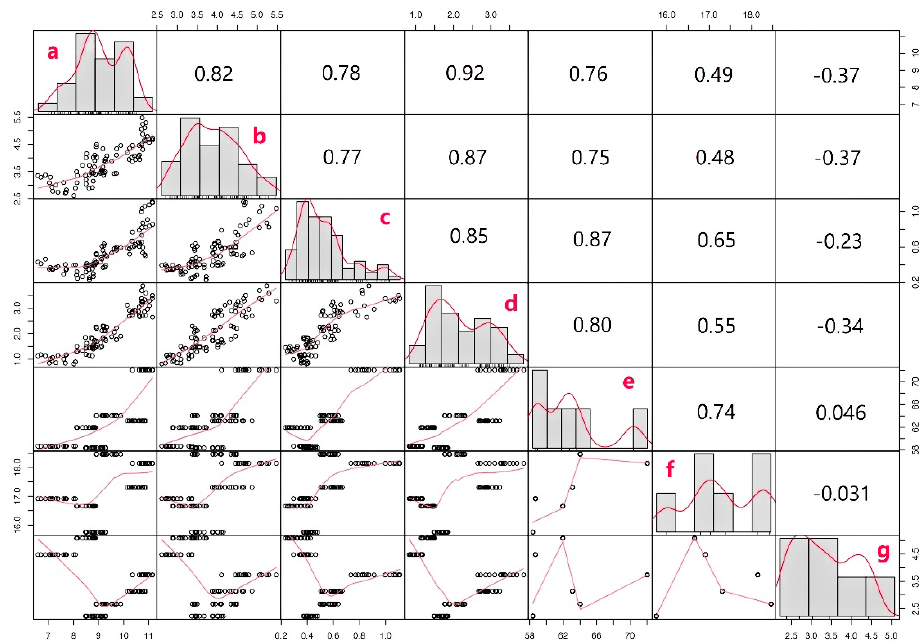
Figure 6. Relationship between flavonoid key enzyme gene expression and content in Tartary buckwheat. Note: a: Rutin, b: Quercetin, c: Kaempferol, d: Kaempferol-3-O-rutin glycoside, e: PAL, f: 4CL, g: ANS.